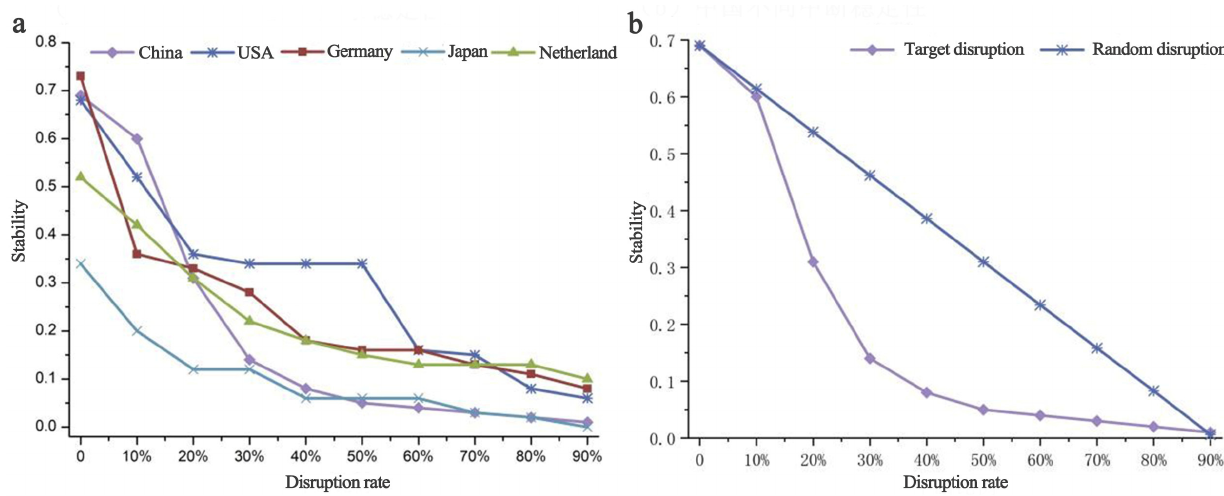
Figure 4. The stability changes in the top five countries ( a ) and China ( b ) under different disruption scenarios in 2018.